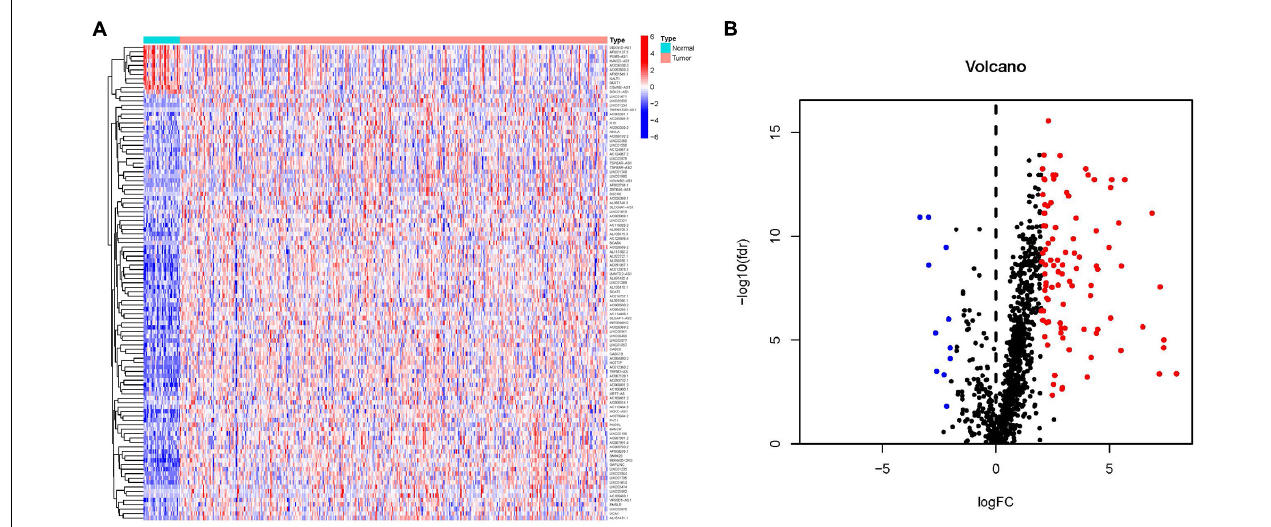
FIGURE 1 | Differentially expressed immune-related long noncoding RNAs (DEIRlncRNAs) for GC. (A) Heatmap and (B) volcano plot showing upregulated (red) and downregulated (blue) DEIRlncRNAs between GC tissues and paracancerous tissues.